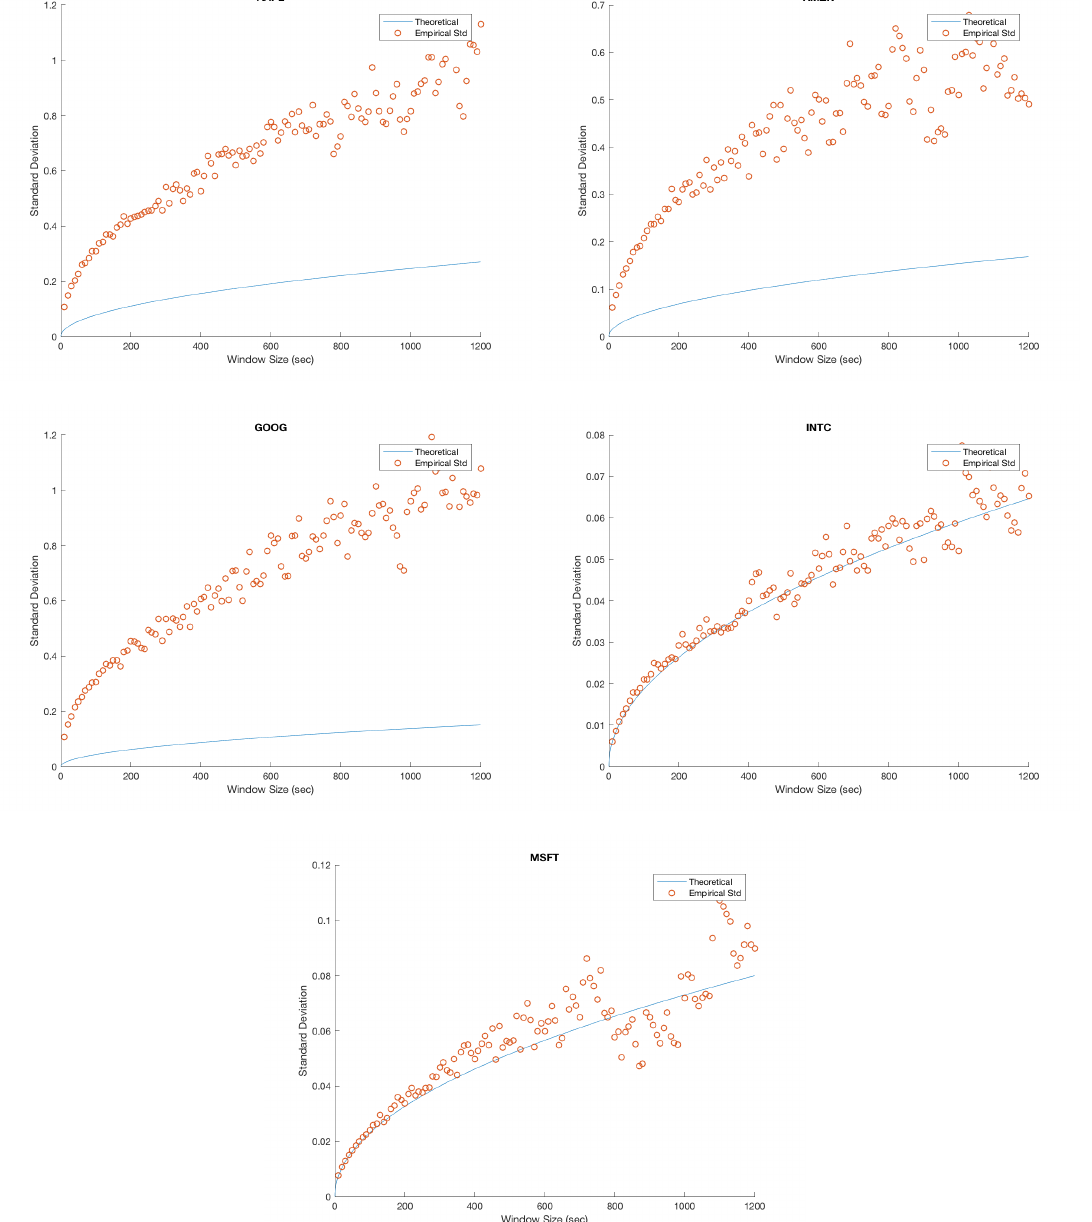
Figure 3. Each figure compares the empirical standard deviation for a fixed window size to the theoretical standard deviation. We have plotted an empirical standard deviation for all n from 10 s to 20 min in step sizes of 10 s. Each empirical standard deviation corresponds to a single point in the scatter plot, and the plotted curve corresponds to the predicted theoretical